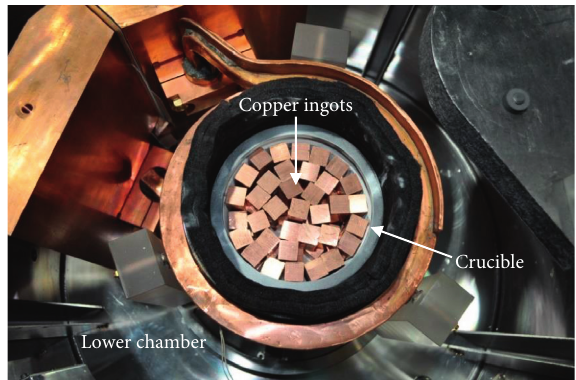
Figure 8: Crucible loaded inside the lower chamber of injection-casting furnace.